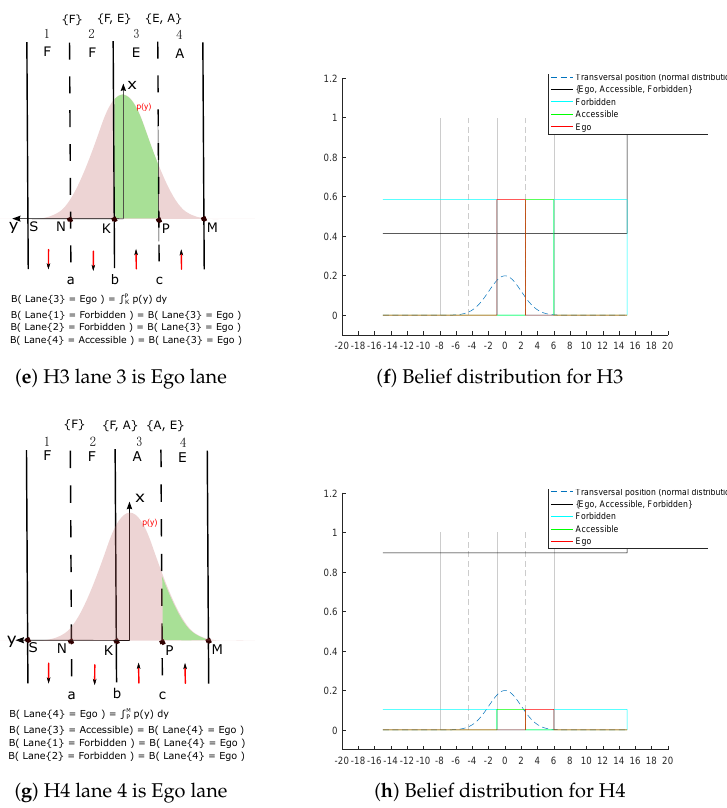
Figure 6. Multi-hypothesis algorithm